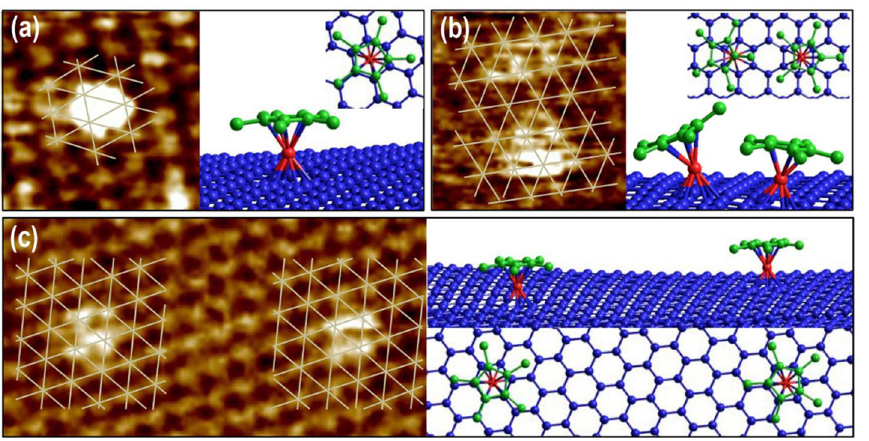
Figure 3. ( a – c ) Detailed STM images of Cp * Ru + fragment bound variously on graphite lattice structure (left image) and their geometric configurations (right image). Each geometric configuration of Cp * Ru + fragment on HOPG substrate show lowest energy states calculated from molecular mechanics force field. Hexagonal meshes shown in STM images depict graphite lattice structure comprising β -site carbons located above hollow site.